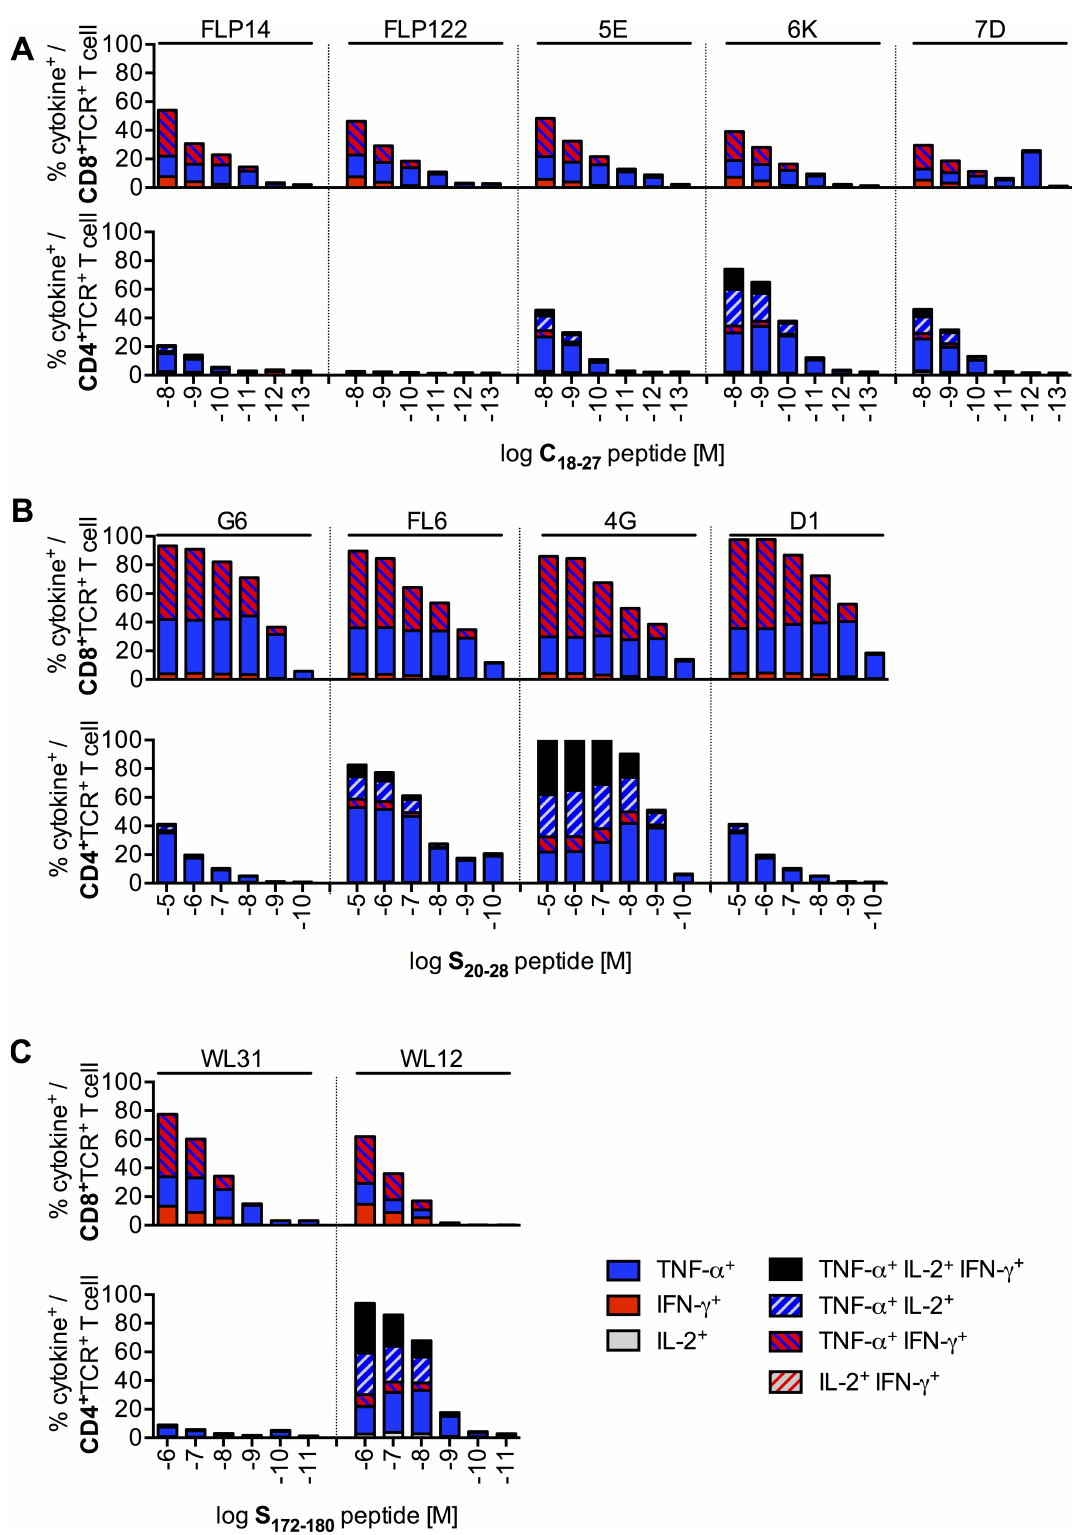
Fig 2. Polyfunctionality of TCR-transduced T cells. After retroviral transduction, CD8 + and CD4 + T cells were separated by magneticactivated cell sorting (MACS). Transduced CD8 + T cells were identifiedwith MHC Streptamers and CD4 + T